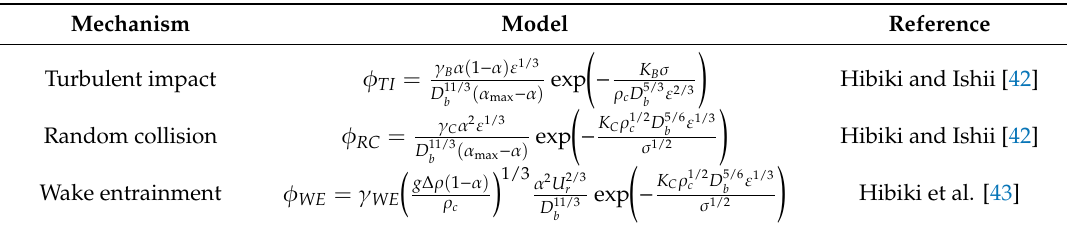
Table 2. Models for bubble breakup and